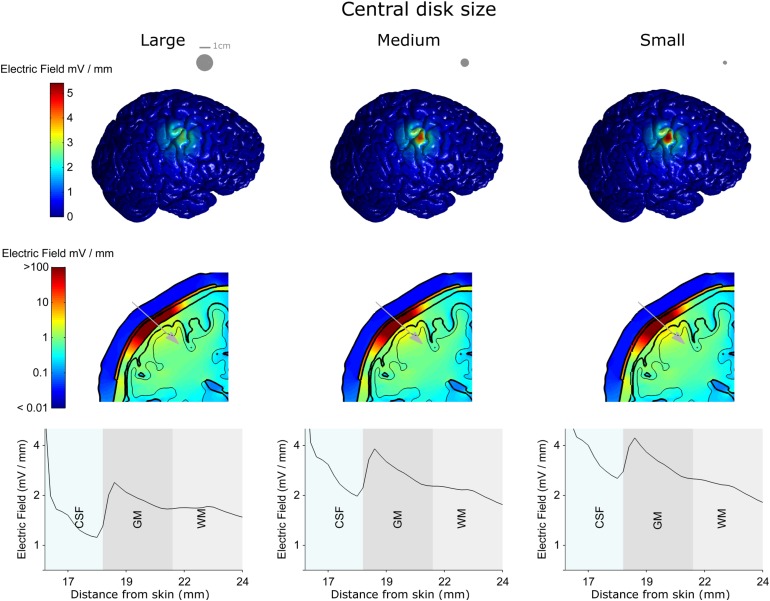
The electro-anatomical head model was used to investigate the effect of disc size on the focality and strength of the electric field reaching the cortex. The left, central and right columns show model data for the large, medium and small disc sizes respectively, when the same 1 mA current is delivered through each spacing. Note – a monopolar configuration was used with these simulations. The top row shows how reducing the disc size (shown as insets in the top row) causes a more focused electric field on the brain. As highlighted in the second and third rows the smaller disc size also causes a stronger electric field in the brain. However, the smaller disc size increases the current density under the electrode (see text). Thus, there is always a trade-off between electric field strength and focality. A 2-dimensional coronal, partial, cross-section is shown in the middle row using a logarithmic color scale. The different model tissues are outlined in black – skin, skull, CSF, gray matter (GM) and white matter (WM). A 1-dimensional plot of the electric field strength along the position indicated by the gray arrow is shown on the bottom row. This shows how the electric field magnitude decreases with distance from the electrode, how it is affected by each tissue type (only CSF, GM, and WM shown for a clearer comparison) and by the disc size.